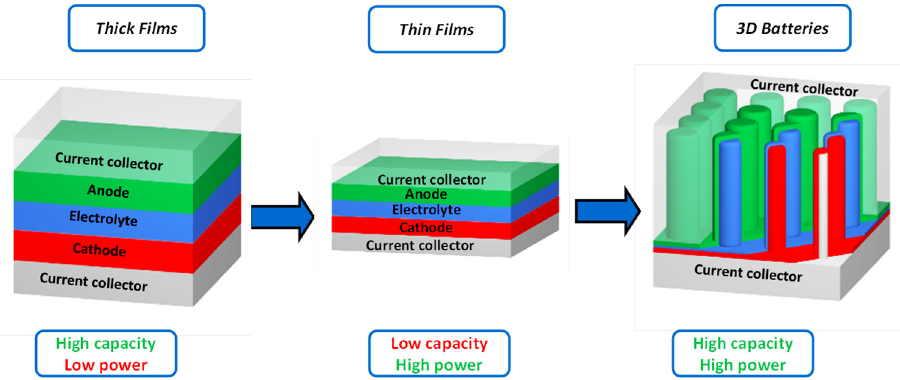
Scheme 1. Illustration showing the evolution from planar thin ‐ film batteries with 1 to 2 μ m thick electrode films to 3D thin ‐ film batteries with sub ‐ micrometre thin films.